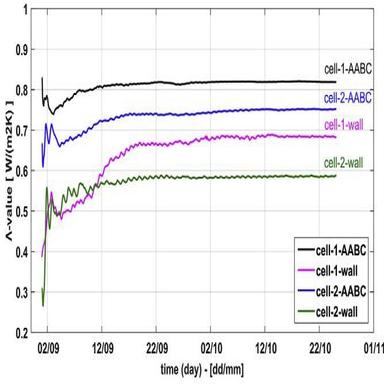
In-situ thermal conductance of the test walls.